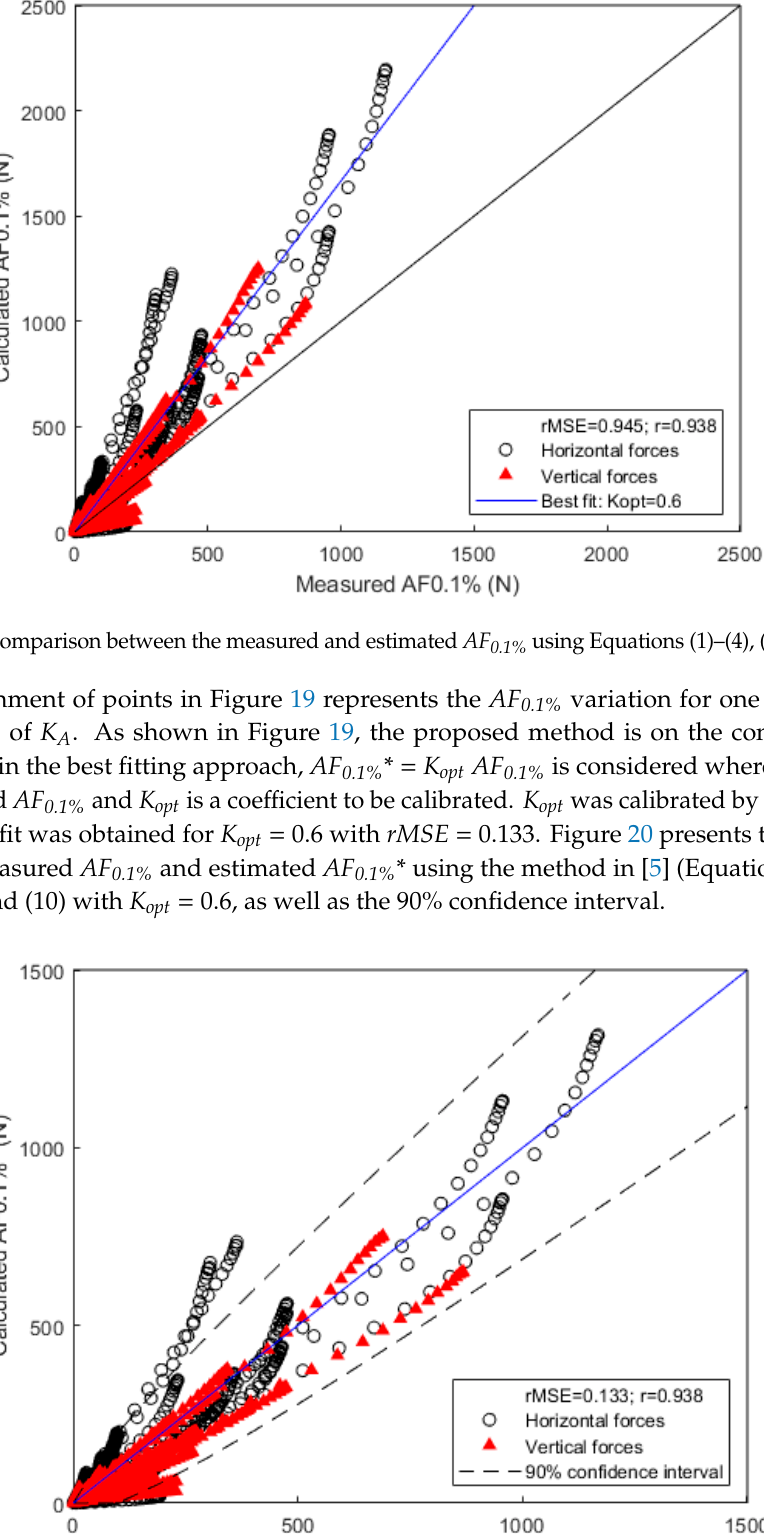
Figure 18. Possible situations when calculating AF 0.1% .